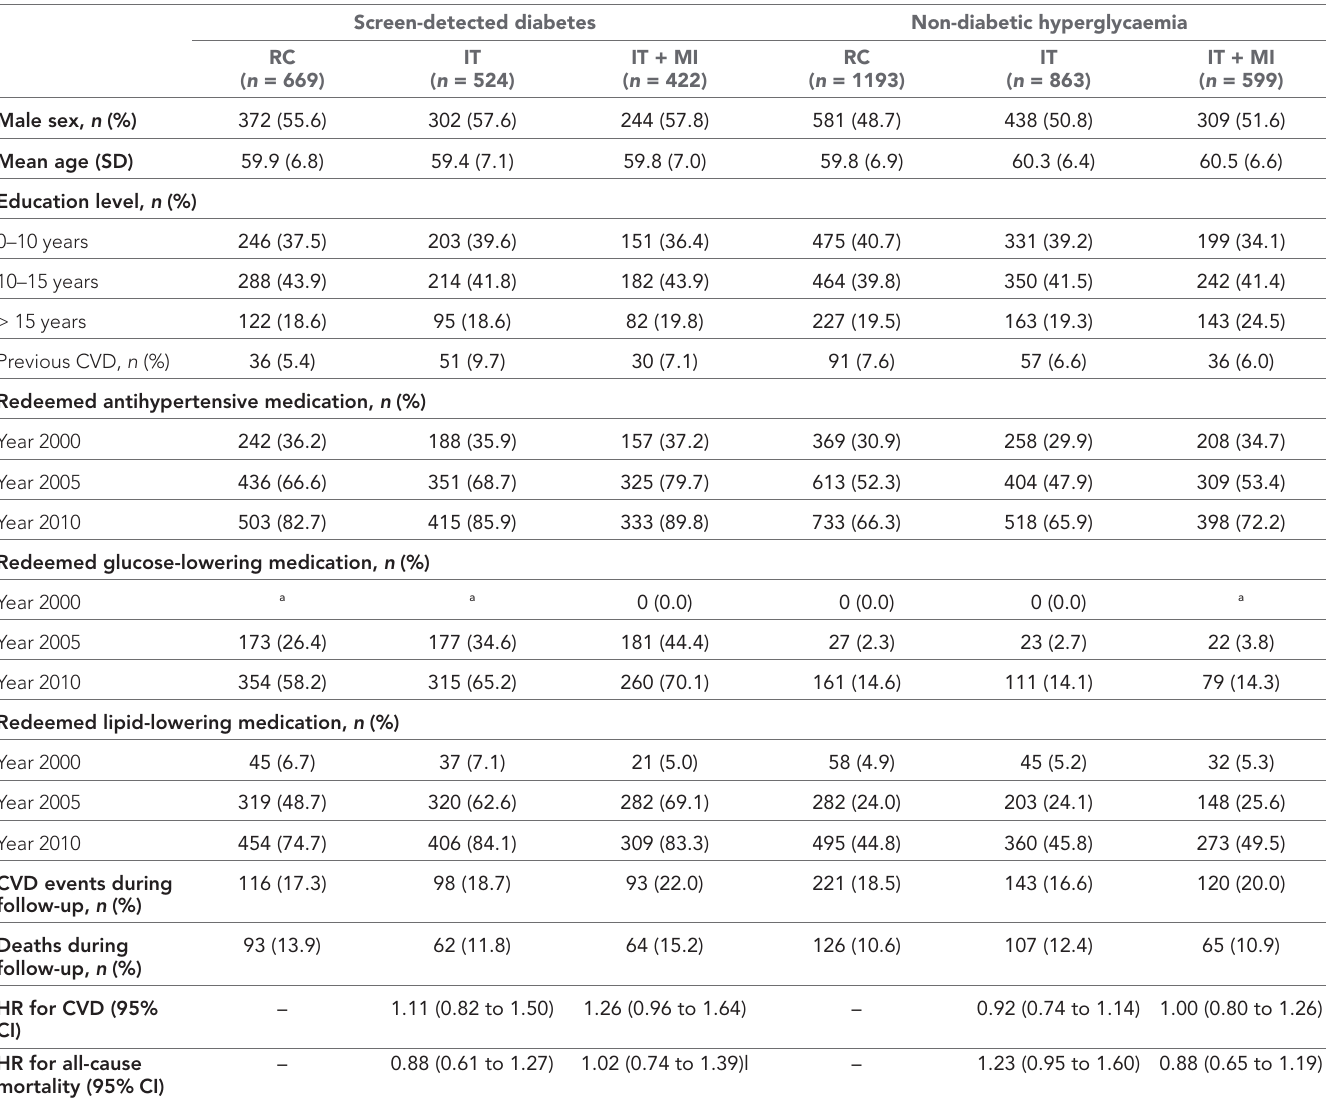
Table 1 Characteristics of individuals with screen- detected diabetes ( n = 1615) and non- diabetic hyperglycaemia ( n = 2655) in the ADDITION- Denmark study, by treatment group Screen- detected diabetes Non- diabetic